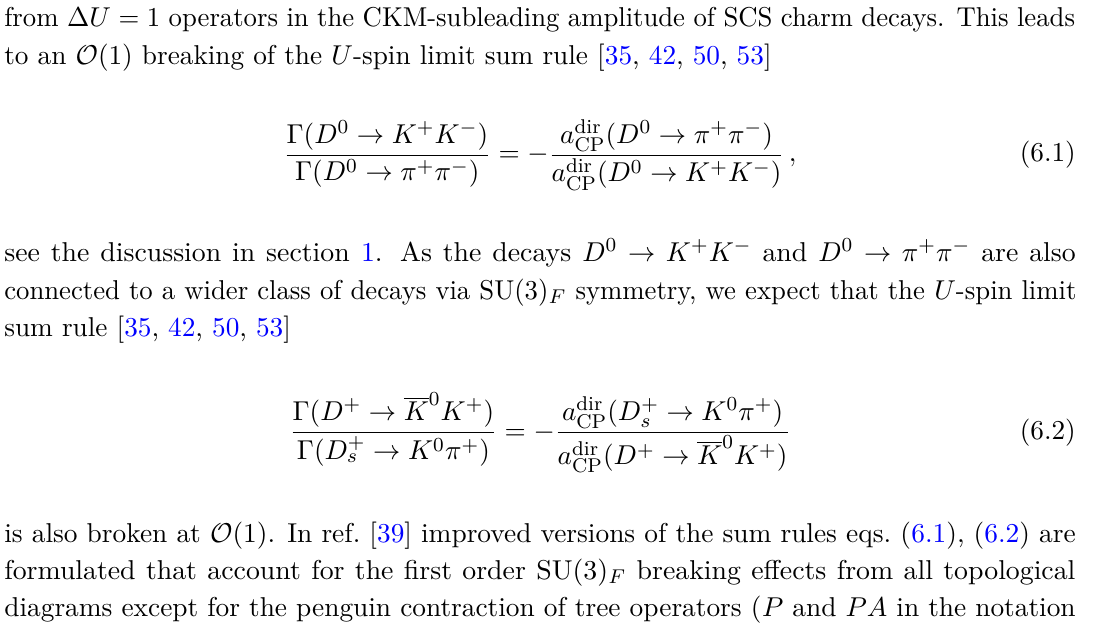
Figure 1 . Illustration of the dependence of 1 / 2 Im(˜ p 1 ) / Im(˜ p 0 ) on Σ a dir For this illustration we fix ∆ a dir and R to their central values and vary Σ a dir KK,ππ CP measured value (blue). In red we show the current experimental data for Σ a dir value for 1 / 2 Im(˜ p ) / Im(˜ p ) including 1 σ errors. For the estimate of the region of 30% U -spin 1 0 breaking (yellow) we assume that the strong phases are O (1) , such that | 1 / 2 Im(˜ p 1 / 2 | ˜ p ˜ p 30% 1 | / | 0 | ≤